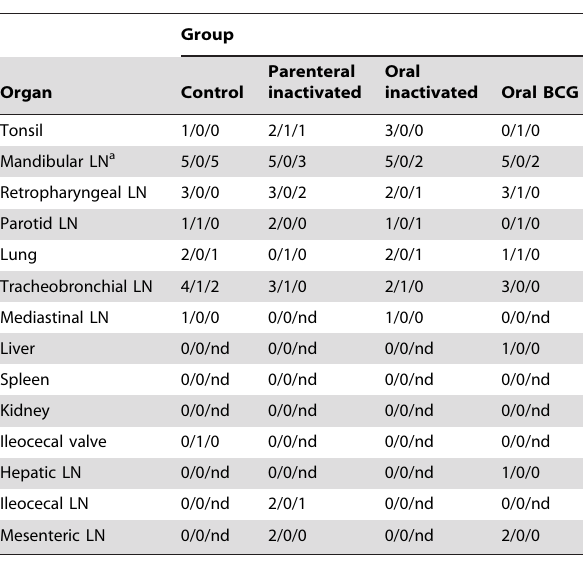
Table 2. Summary of pathology findings expressed as number of animals showing macroscopic lesions, number of animals showing only microscopic lesions, and number of animals with AFO in Ziehl-Neelsen stained sections, separated by